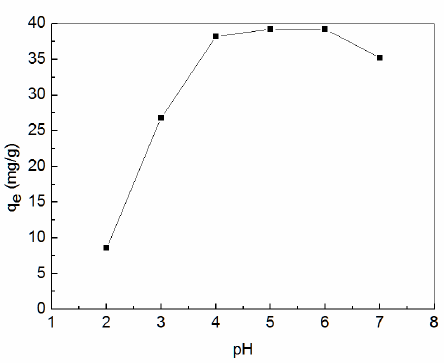
Figure 5. Effect of initial solution pH on equilibrium adsorption capacity ( q e ).